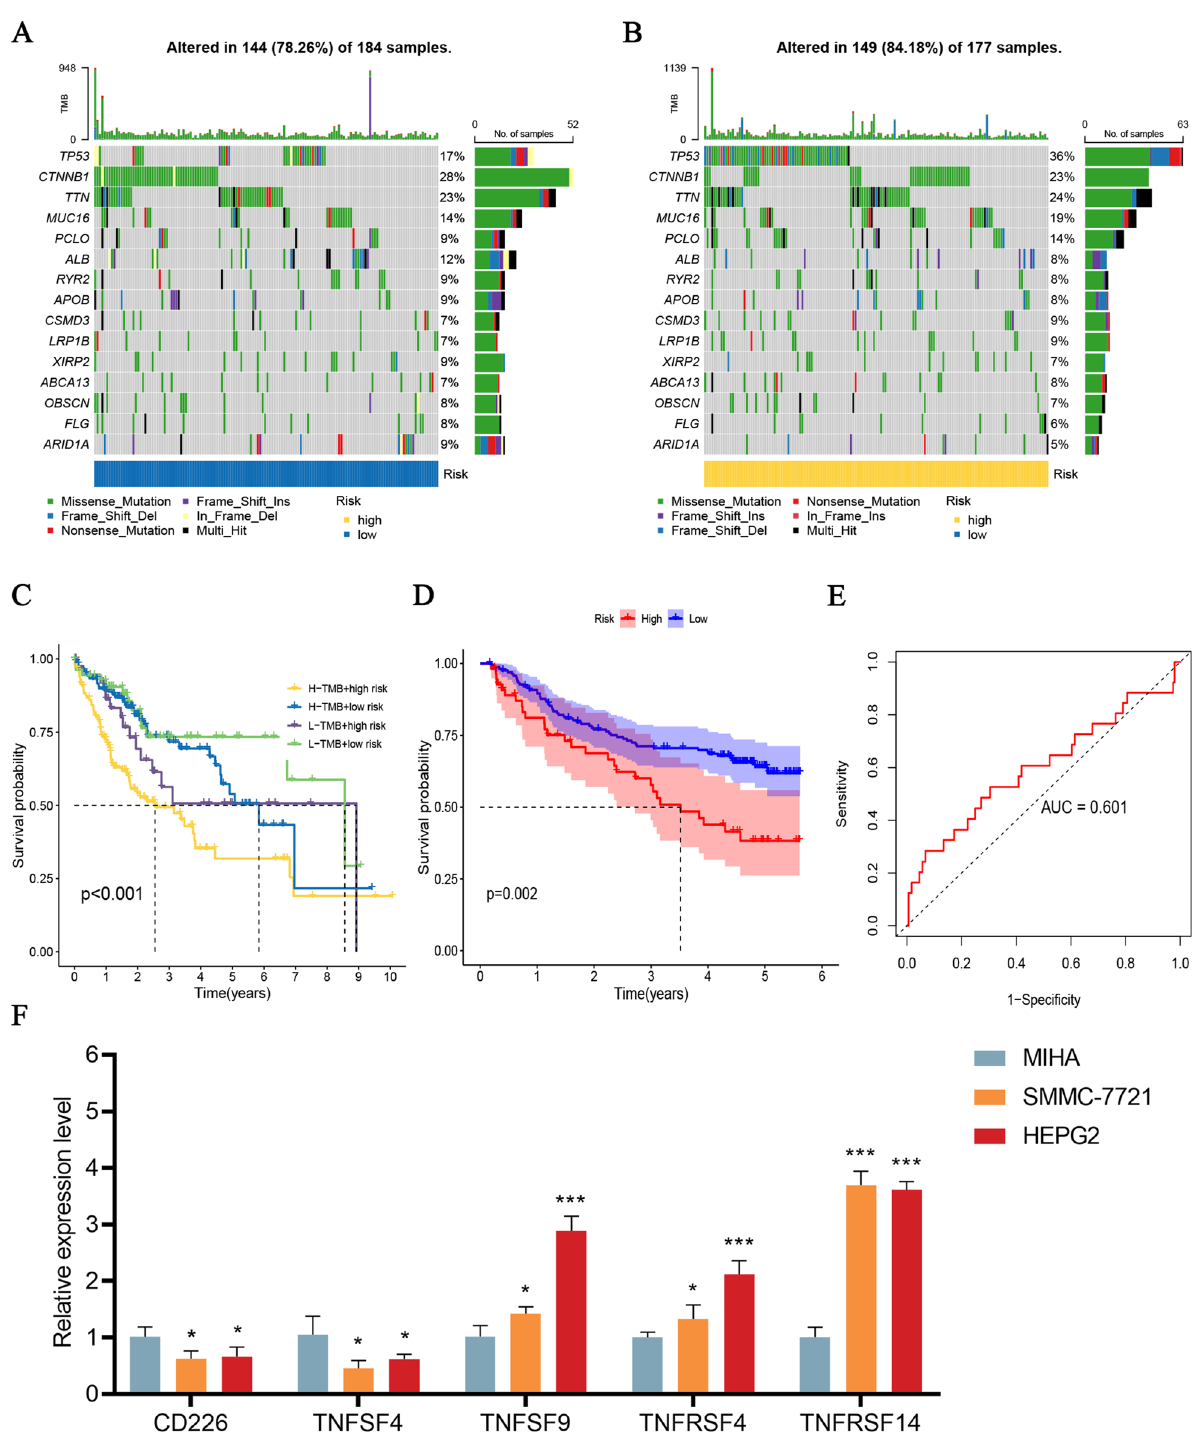
Figure 8. Somatic mutation analysis and external validation of cuproptosis ‐ related ICGs model. ( A , B ) The waterfall plot showing the difference in somatic mutation features between the low- and high-risk populations. ( C ) Kaplan–Meier survival curves of the prognostic signature combined with TMB. ( D ) OS in the GSE14520 dataset. ( E ) The ROC curves for 1-year OS in the GSE14520 dataset. ( F ) Expression levels of TNFRSF4, TNFRSF14, TNFSF4, TNFSF9, and CD226 in HCC cell lines. * p < 0.05; *** p <